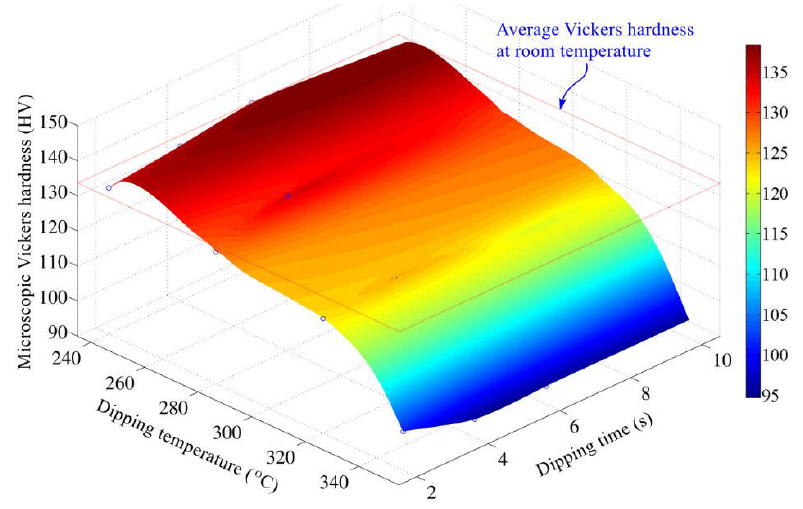
Figure 4. Variation of Vickers hardness of Cu substrates with dipping temperature and dipping time for C11000 foils.